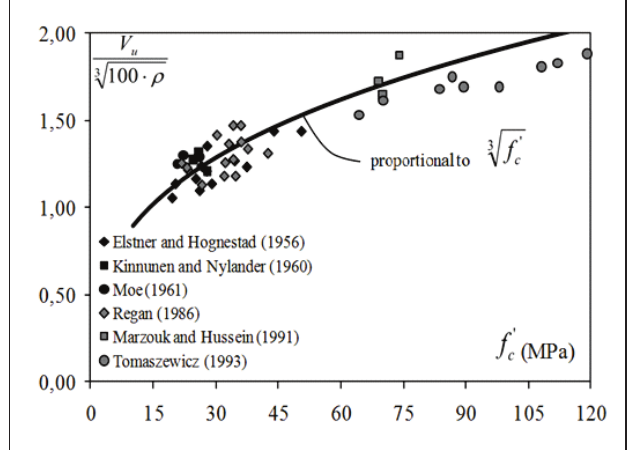
Figure � � �nfluence of the co�pression concrete strength on the punching resistance of flat slabs